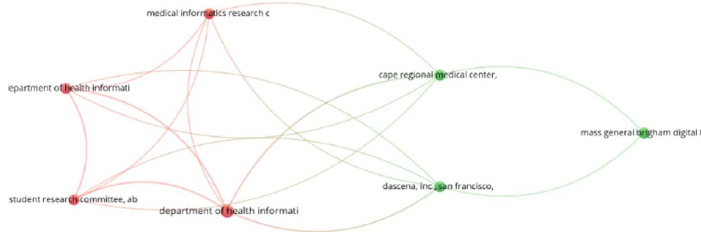
Figure 13. Author citations by the organization.